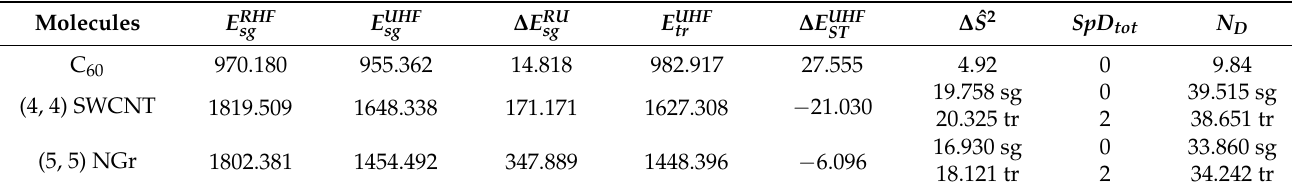
Table 1. Energies (kcal/mol) and emergent spin characteristics of the sp 2 molecules in the ground state.